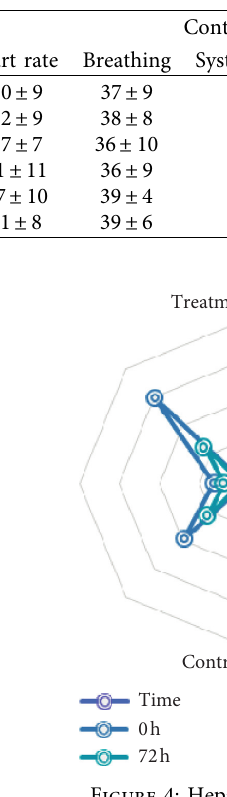
Figure 3: Changes in vital signs. Table 3: Changes in vital signs.